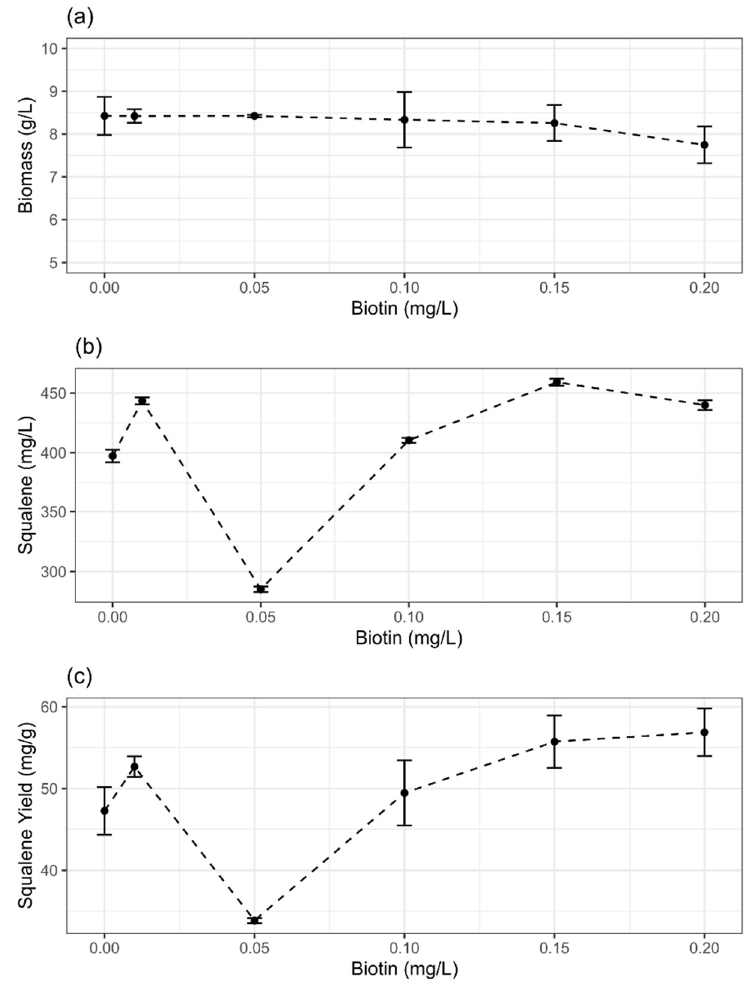
Figure 2. Effects of biotin supplementation on the ( a ) biomass, ( b ) squalene concentration, and ( c ) squalene yield of ATCC 26185 strain. The data are provided for 72 h grown culture and expressed as mean ± SD of triplicate experiments. DMSO was added to the medium without biotin (0 g/L) as a negative control.